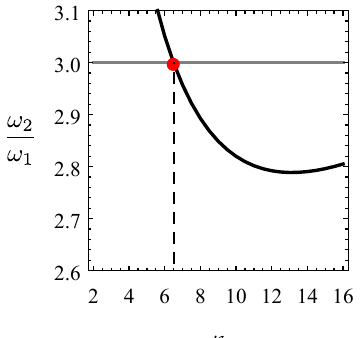
Figure 2. The ratio between second and first natural frequency vs the elastic spring stiffness. Red marker denotes the internally resonant